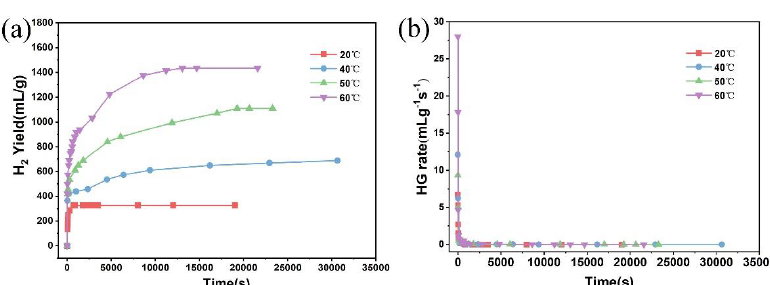
Figure 8. ( a ) Hydrogen generation curves and ( b ) hydrogen generation rate of the MgH 2 -3 wt % LiH-BM in water at different bath temperatures.